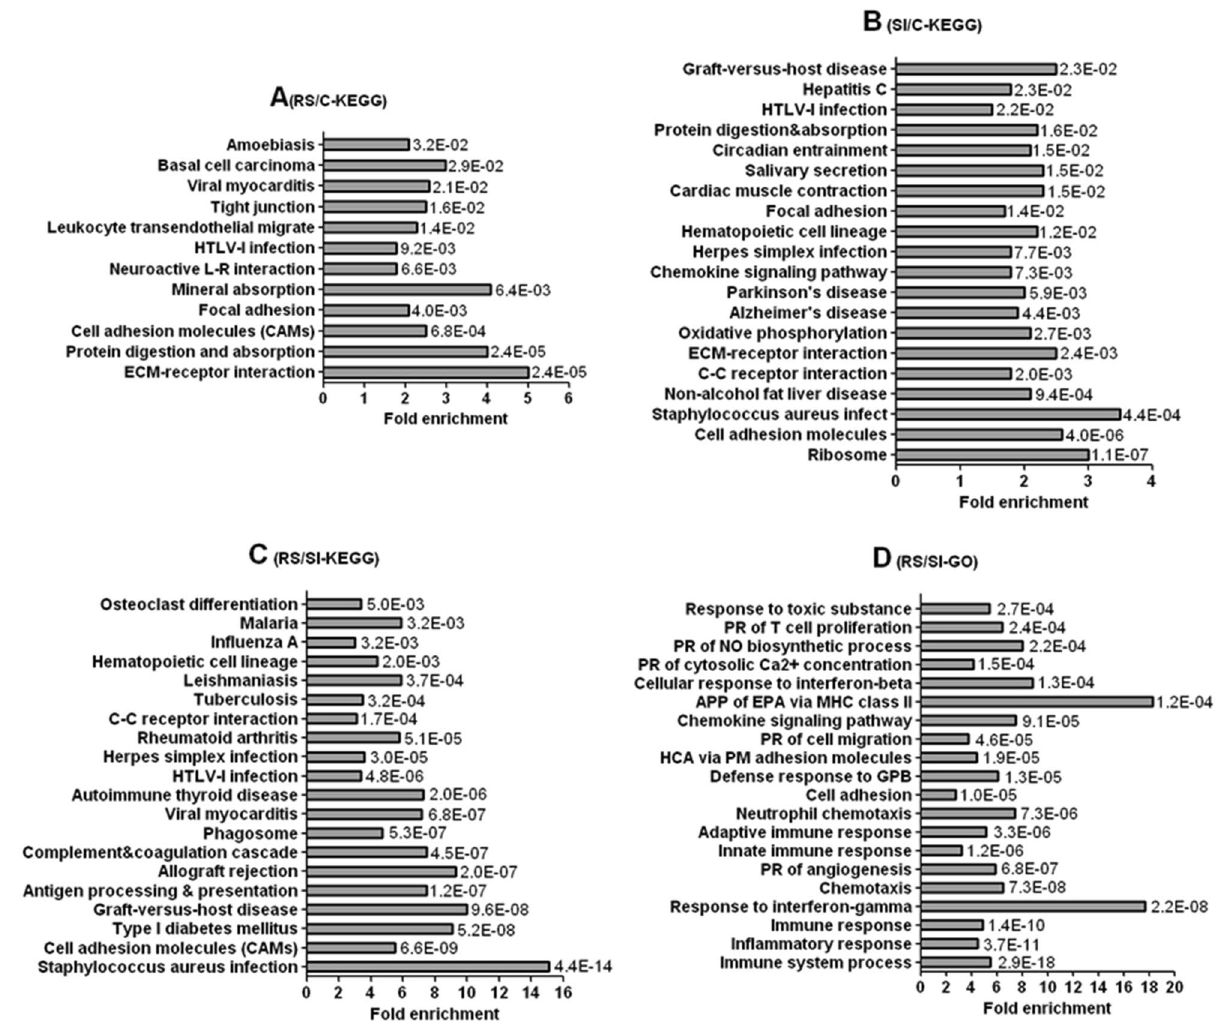
Figure 4. Pathway enrichment analysis of DE genes identified by the RNA-seq. Panel ( A ) shows the 12 KEGG pathways significantly enriched by DE genes between RS and control female offspring (RS/C), and panel ( B ) shows the top 20 KEGG pathways significantly enriched by DE genes between SI and control offspring (SI/C). Panels ( C ) and ( D ) show the top 20 KEGG pathways and GO biological process terms, respectively, which were significantly ( P < 0.05) enriched by DE genes between RS and SI offspring (RS/SI). Bars are the fold enrichment of pathways and the values next to the bars are the P values. APP antigen processing and presentation, C–C cytokine–cytokine, EPA exogenous peptide antigen, GPB Gram-positive bacterium, HCA homophilic cell adhesion, L–R ligand–receptor, PM plasma membrane, PR positive regulation. A formal permission for the use of the KEGG pathway database was obtained from Kanehisa